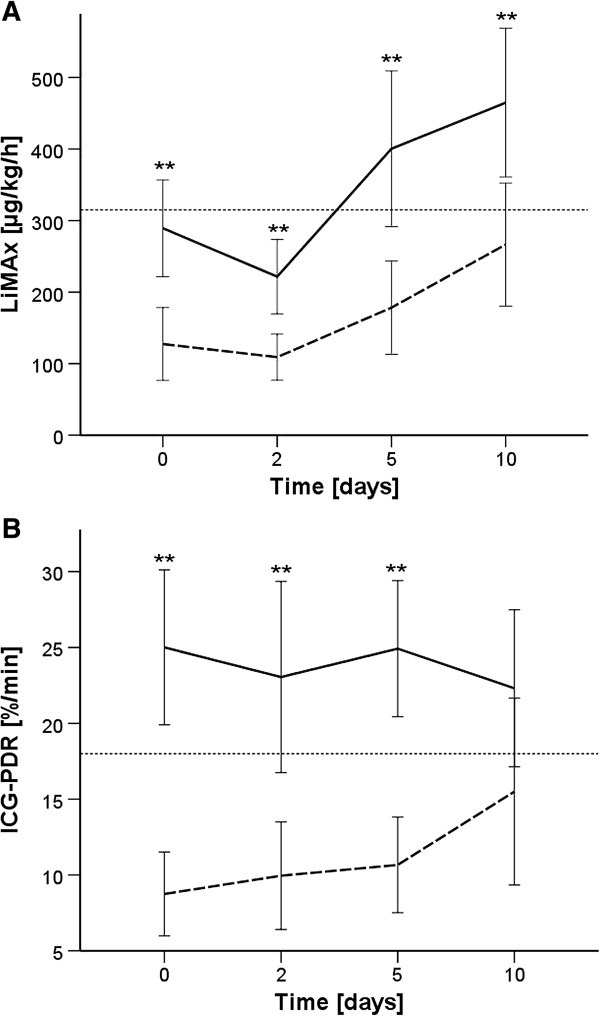
Progression of liver parameters by patient outcome. (A) Maximal liver function capacity (LiMAx). (B) Indocyanine green plasma disappearance rate (ICG-PDR). Interrupted line, group A; continuous line, group B. Mean values with 95% confidence interval. **P < 0.01.